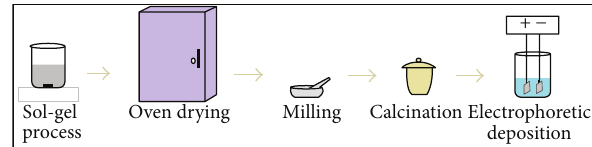
Figure 1: Schematic diagram of the experimental